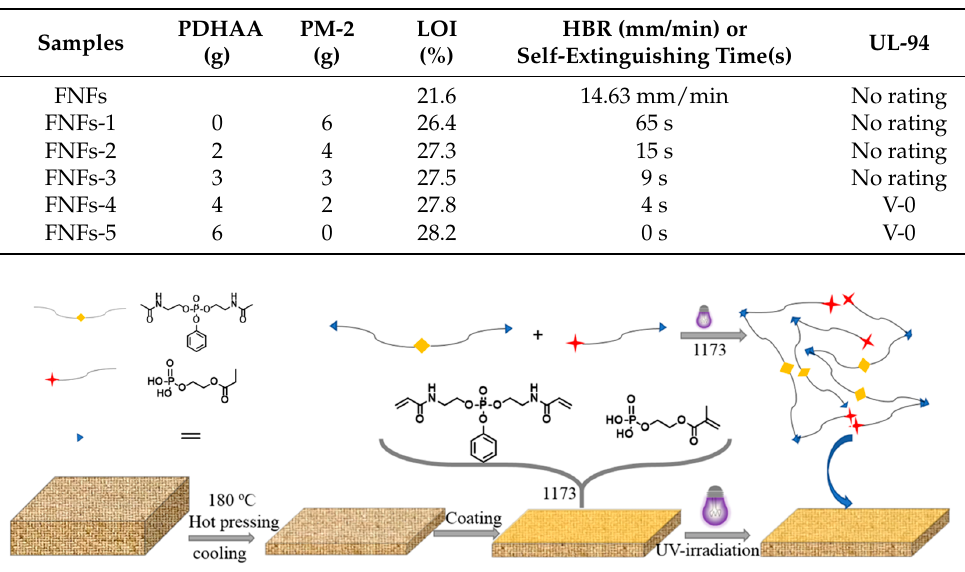
Figure 1. Preparation process of the coated FNFs.